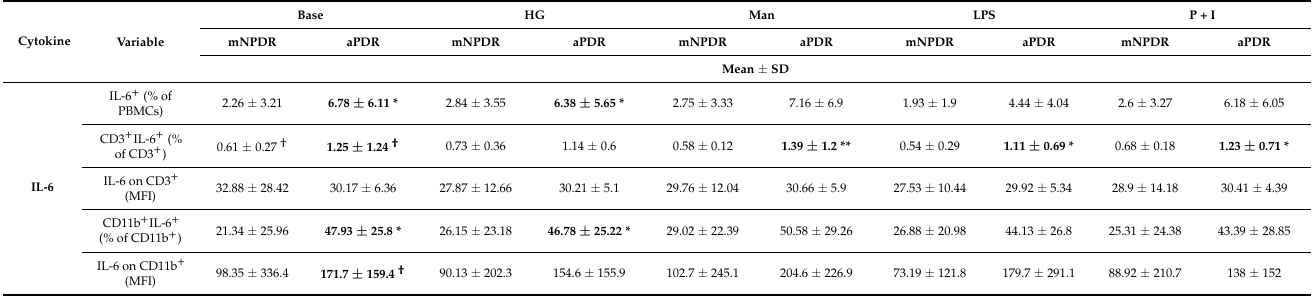
Table 5. Cytokine expression of PBMCs from aPDR vs. mNPDR patients in different culture